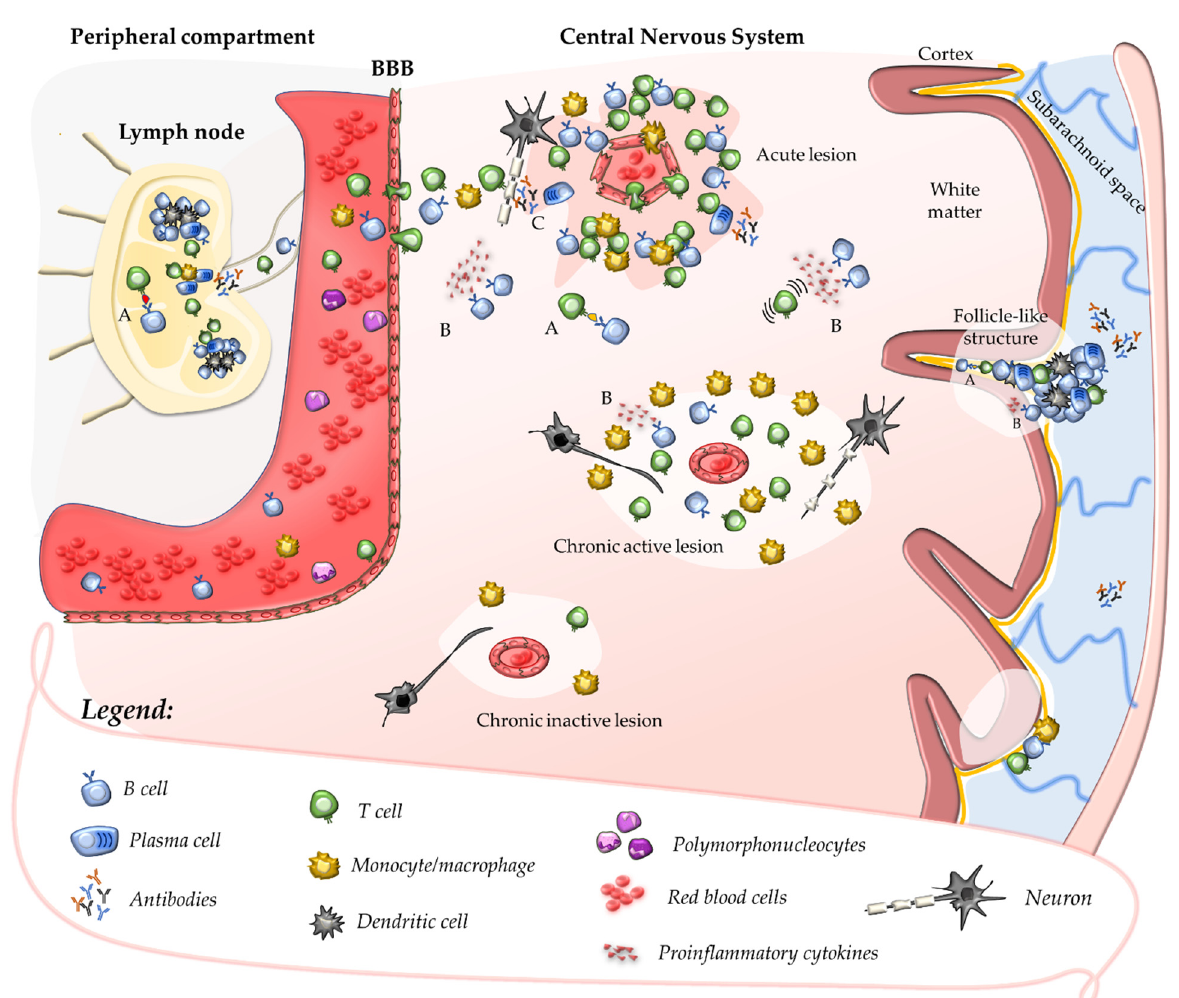
Figure 1. B cells play a pleiotropic role in MS pathogenesis. B lymphocytes act as